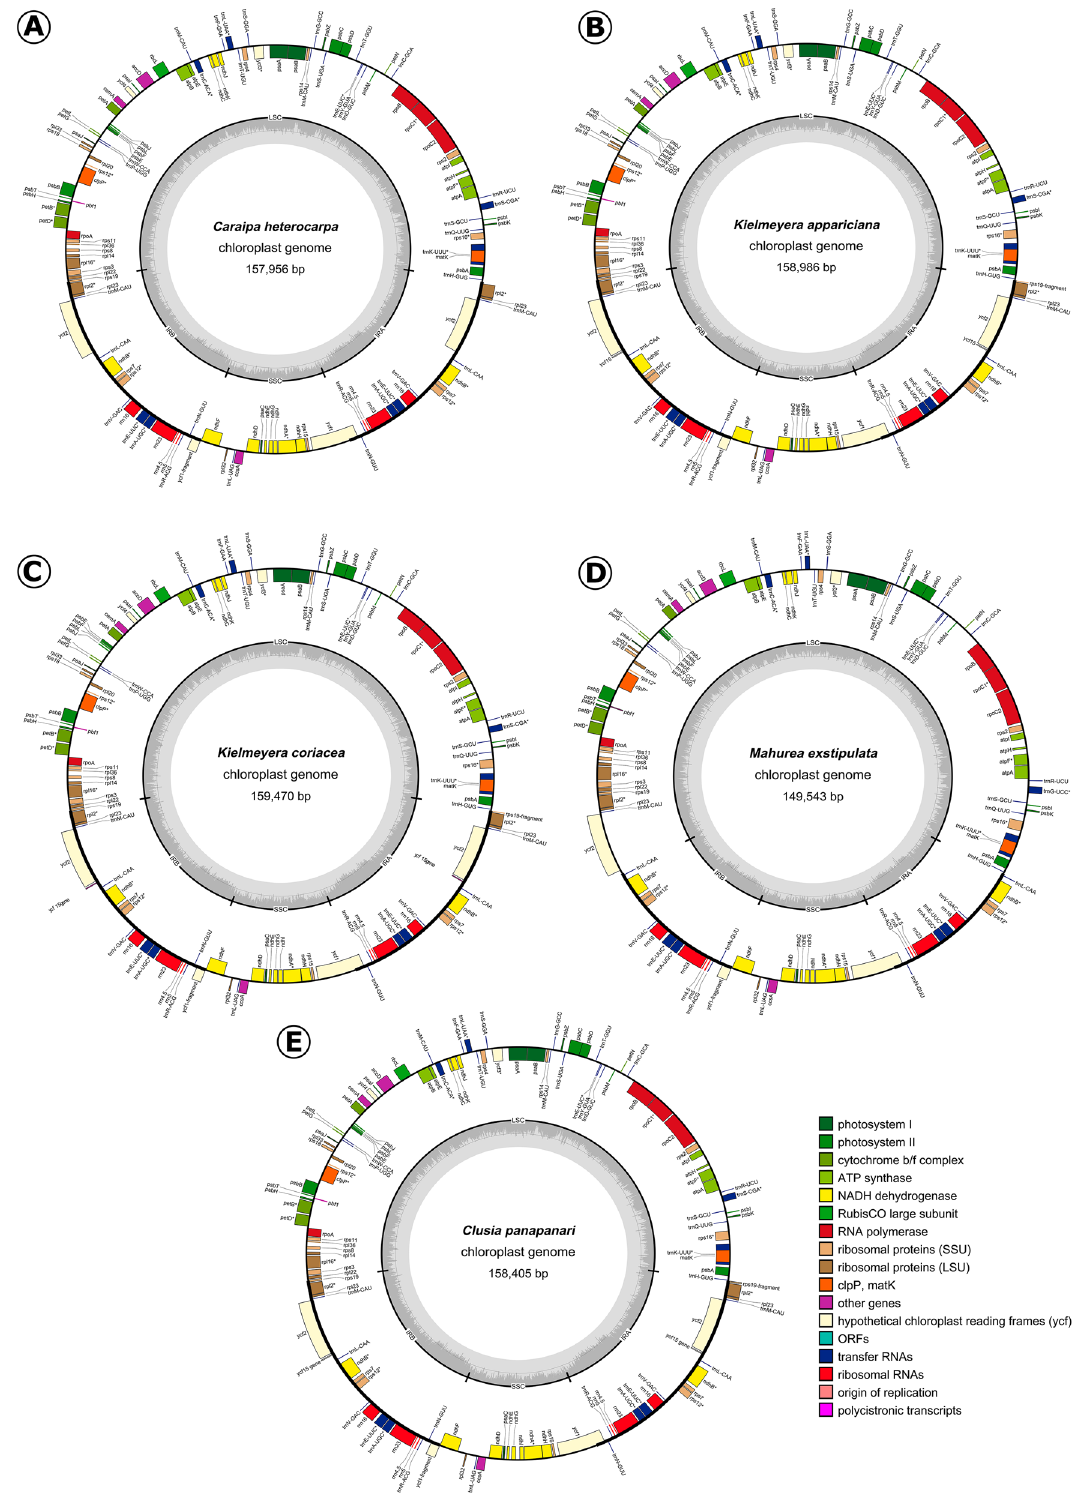
Figure 1. Circular map of the five complete clusioid plastomes. ( A ) Caraipa heterocarpa , ( B ) Kielmeyera appariciana , ( C ) K. coriacea , ( D ) Mahurea exstipulata , ( E ) Clusia panapanari . The genes represented outside the circle are transcribed counterclockwise and those inside the outer circle are transcribed clockwise. Genes are colored according to their functional groups following the legend. The inner gray graphs indicate the GC content across the